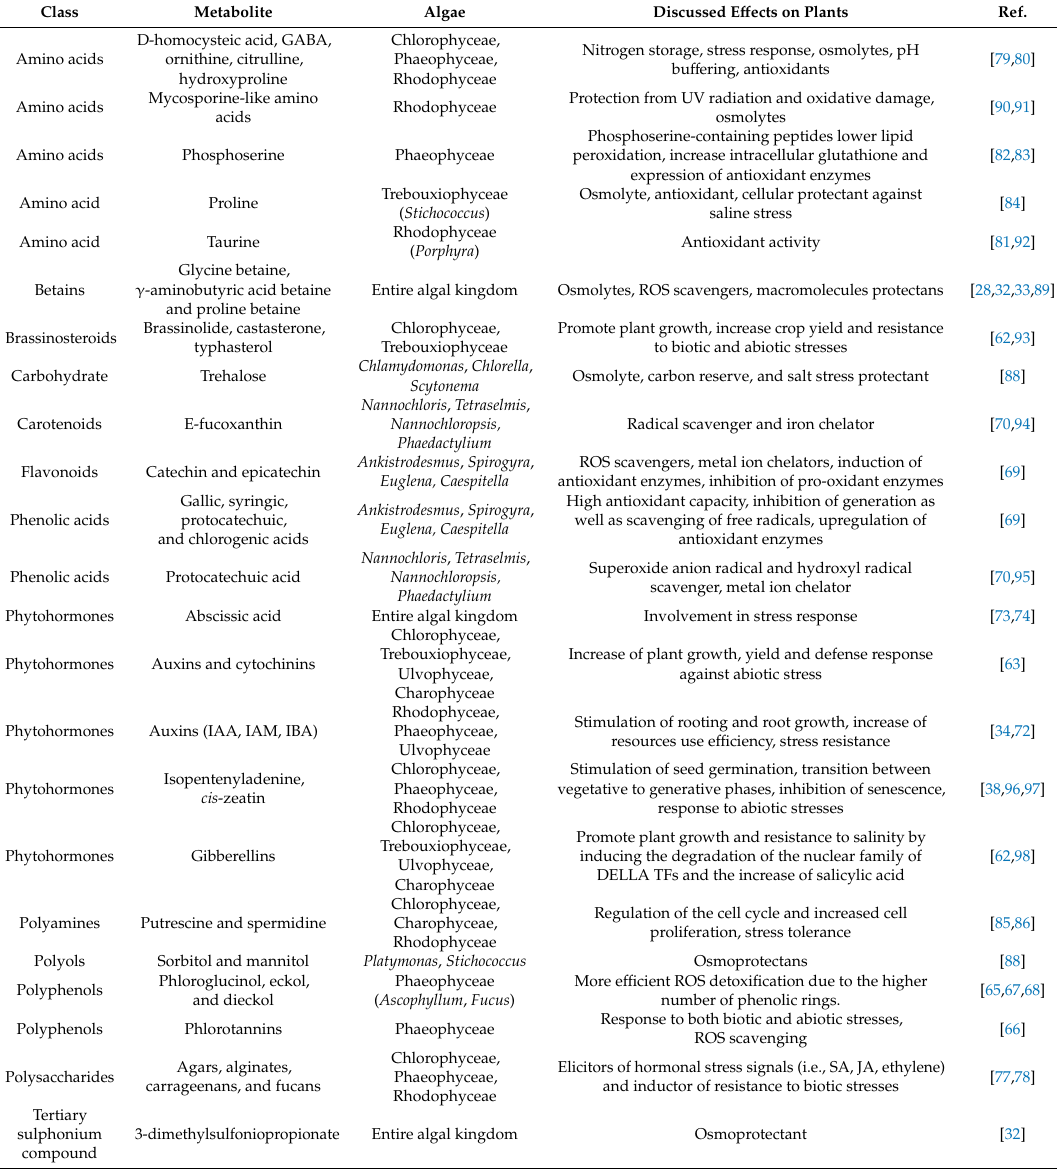
Table 1. A summary of representative bioactive compounds in algal extracts and their e ff ects on plants under salinity. GABA: γ -aminobutyric acid, IAA: indole-3-acetic acid, IAM: indole-3-acetamide, IBA: indole-3-butyric acid, ROS: Reactive Oxygen